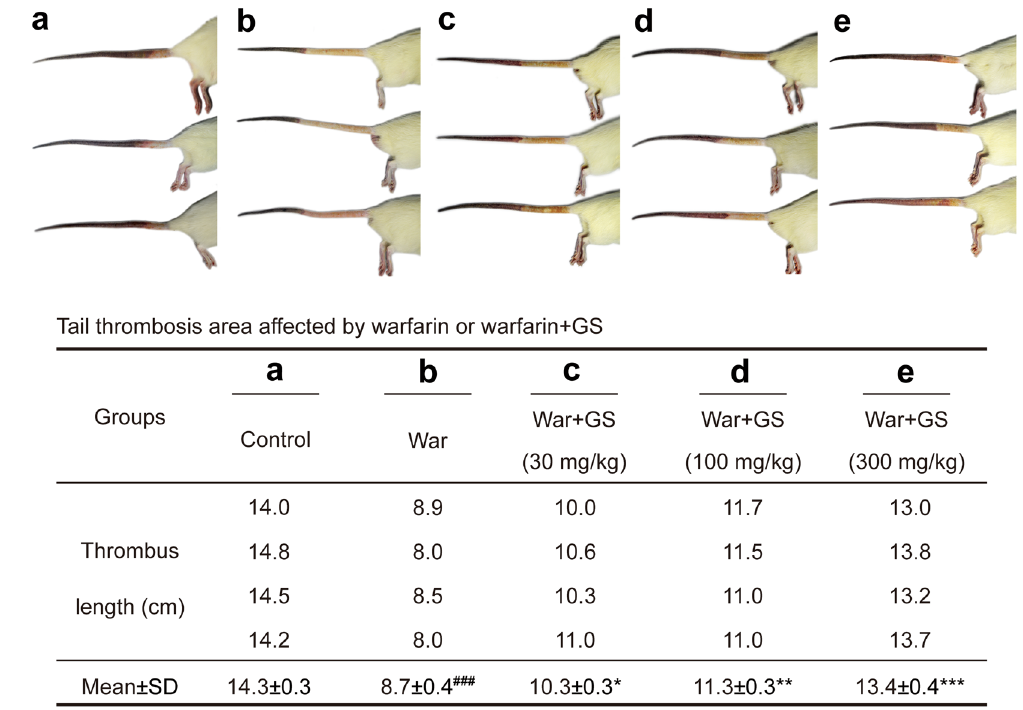
Figure 3. Effects warfarin alone, or administered with GS on rat tail thrombosis induced by K-carrageenan. Upper panel, the tail thrombosis induced by K-carrageenan ( a ) and attenuated by one-week warfarin (0.4 mg/ kg/day) ( b ); ( c – e ) one-week warfarin and three-week warfarin co-administered with GS (30, 100 and 300 mg/ kg/day) produced GS dose-dependent antagonism on warfarin’s anti-coagulation effect. Lower panel shows the related quantitative analysis. ### P < 0.001, statistically significant difference compared with group A; * P < 0.05; ** P < 0.01; *** P < 0.001 compared with group B (n = 4 per group).